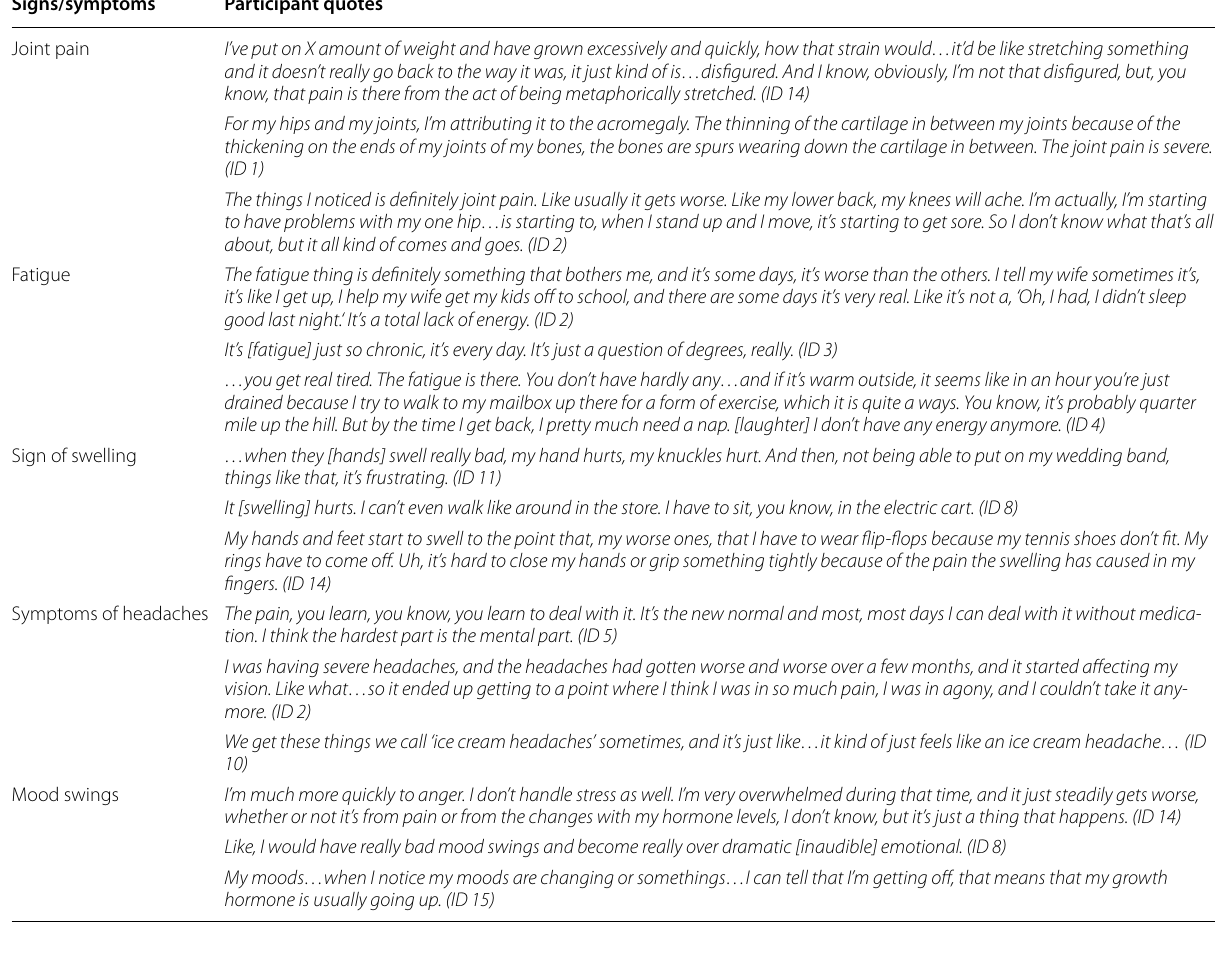
Table 2 Symptoms and signs of acromegaly spontaneously reported Signs/symptoms Participant